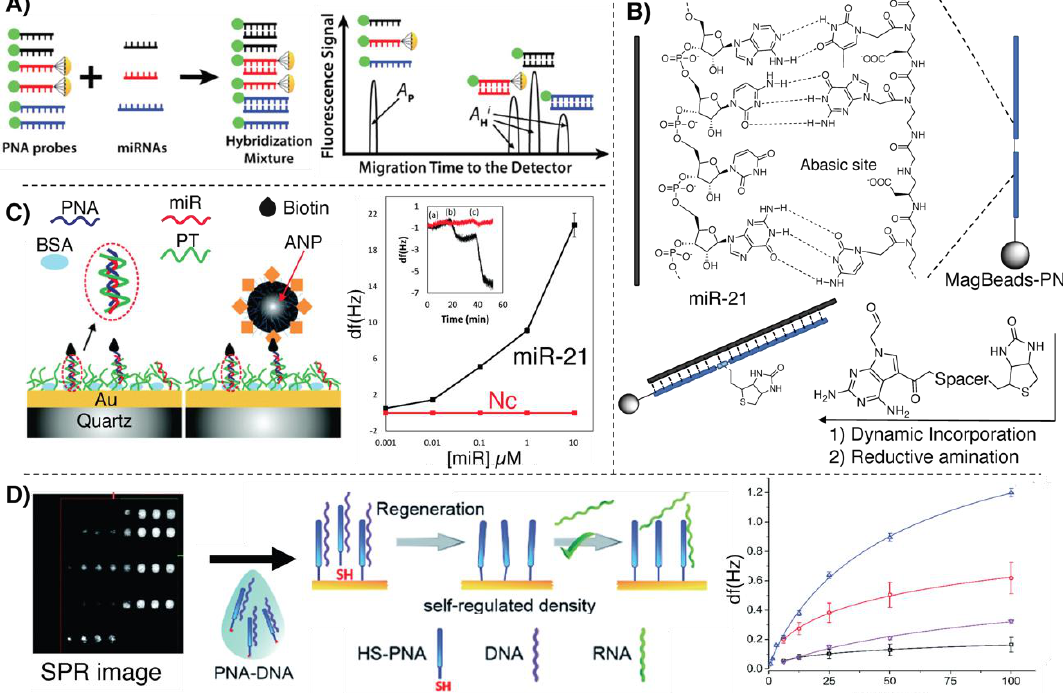
Figure 10. Illustration of other miR-detection assays based on PNAs. ( A ) DQAMmir analysis as adapted from [114]. Copyright 2016 American Chemical Society. ( B ) Bio-labeling of a PNA:miR-21 duplex with a biotinylated reactive base described in [115]. (C ) Detection of miR-208a using the SPR-based methodology, adapted from [44]. Published by the Royal Society of Chemistry. ( D ) Illustration of the QCM-based methodology adapted from [116]. Published by the Royal Society of Chemistry.